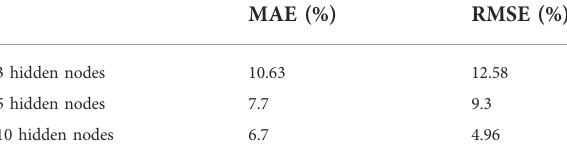
TABLE 2 Evaluation of power demand prediction for 1